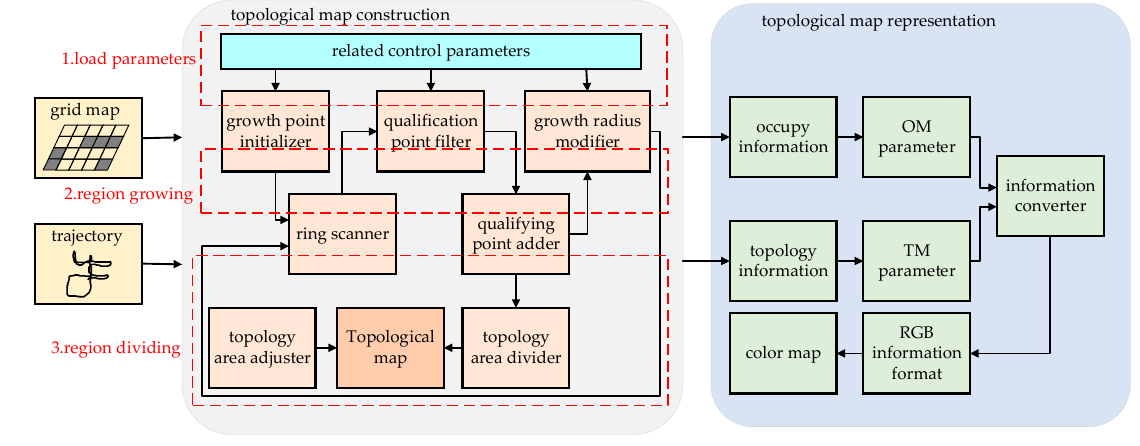
Figure 1. The architecture of the topological map construction system.